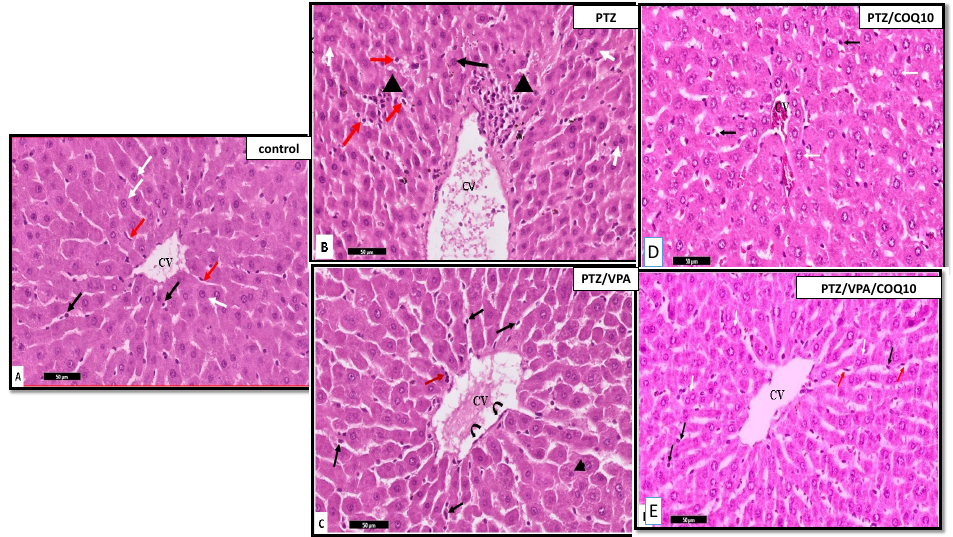
Figure 9. Photomicrographs of the rat liver section at the peri-central vein area of all of the rat groups. ( A ) Control group showing the polyhedral hepatocytes arranged radially in cords around the central vein (CV), with normal vesicular basophilic nuclei (white arrow). Notice the thin flat endothelial lining of the blood sinusoids (red arrows) and Von kupffer cells (black arrow). ( B ) PTZ group showing the hepatocytes with normal vesicular nuclei (arrow); some of them have a deep acidophilic cytoplasm. The binucleated hepatocytes are shown with white arrows. Notice the focal aggregation of mononuclear inflammatory cells between the hepatocytes with deep acidophilic cytoplasm and small, shrunken, deeply stained nuclei (Head arrow), and the sparse presence of the hypertrophied intra-sinusoidal cells (Von Kupffer cells) (red arrow) in-between the hepatocytes. ( C ) PTZ/VPA group showing the hypertrophied Von Kupffer cells ( → ) in-between the hepatocytes, which are surrounded by flat and low cubical cells (curved arrow). Notice the micro-vacuolation of the cytoplasm of some of the hepatocytes with small pyknotic nuclei (Head arrow), and the mononuclear cellular infiltration in-between the hepatocytes (red arrow). ( D ) PT Z/COQ10 showing the hepatocytes with normal architecture near to the control. ( E ) PTZ/VPA/COQ10 showing the polyhedral hepatocytes with normal vesicular basophilic nuclei and granular cytoplasm (white arrow). Notice that a few hepatocytes appeared with slightly vacuolated cytoplasm, especially in the perinuclear region (black arrows), the thin endothelial lining of the blood sinusoids (red arrows), and ( E ). H&E stain-group/scale bar (( A – I ) 50 µ